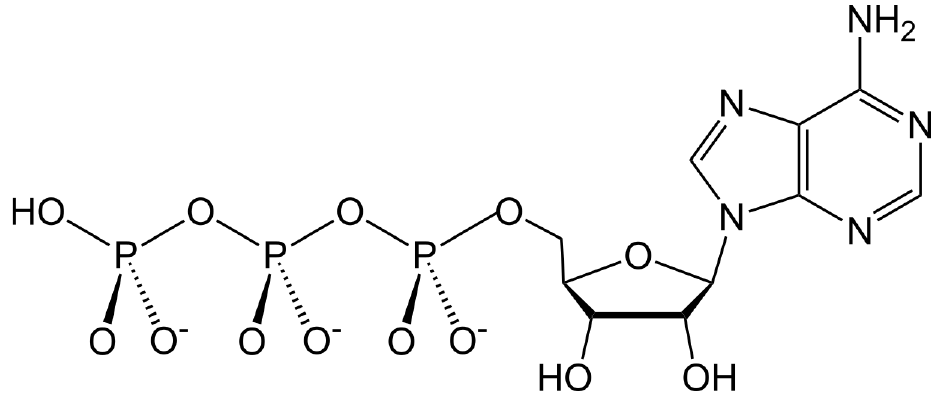
Figure 4. Structure of